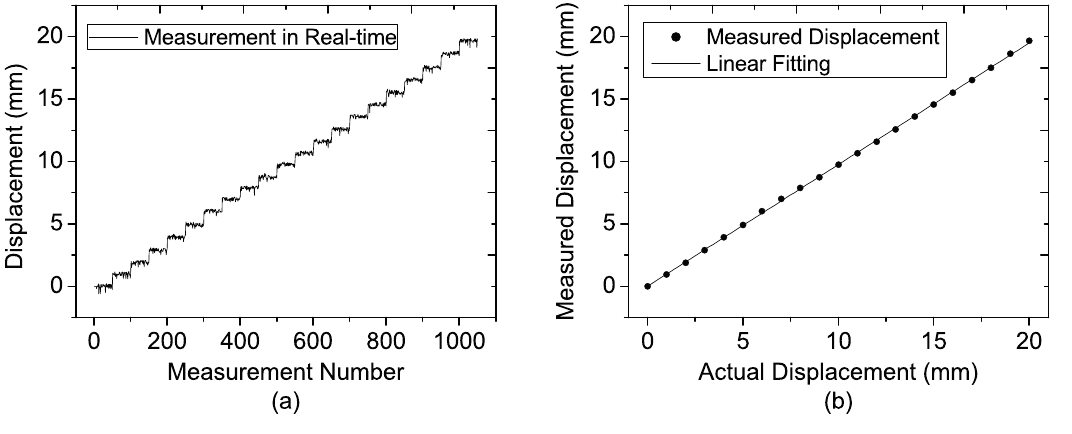
Figure 13. Measured results of the target located at the distance of 30 m at each step for ( a ) 50 single-measurement results; ( b ) Average of the 50 single-measurement results.